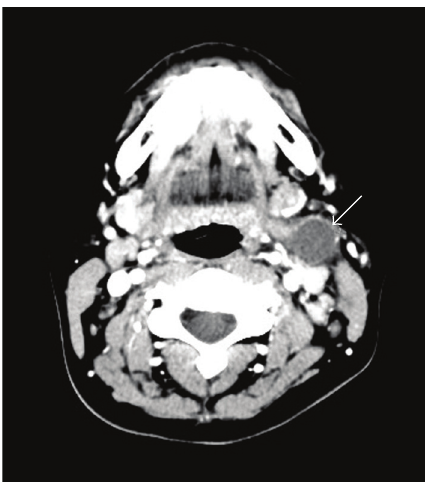
Figure 1: Axial contrast-enhanced CT. A 2cm well-circumscribed, low attenuation mass (arrow) is present at the expected location (jugulodigastric (Level 2) lymph node or second branchial cleft cyst).